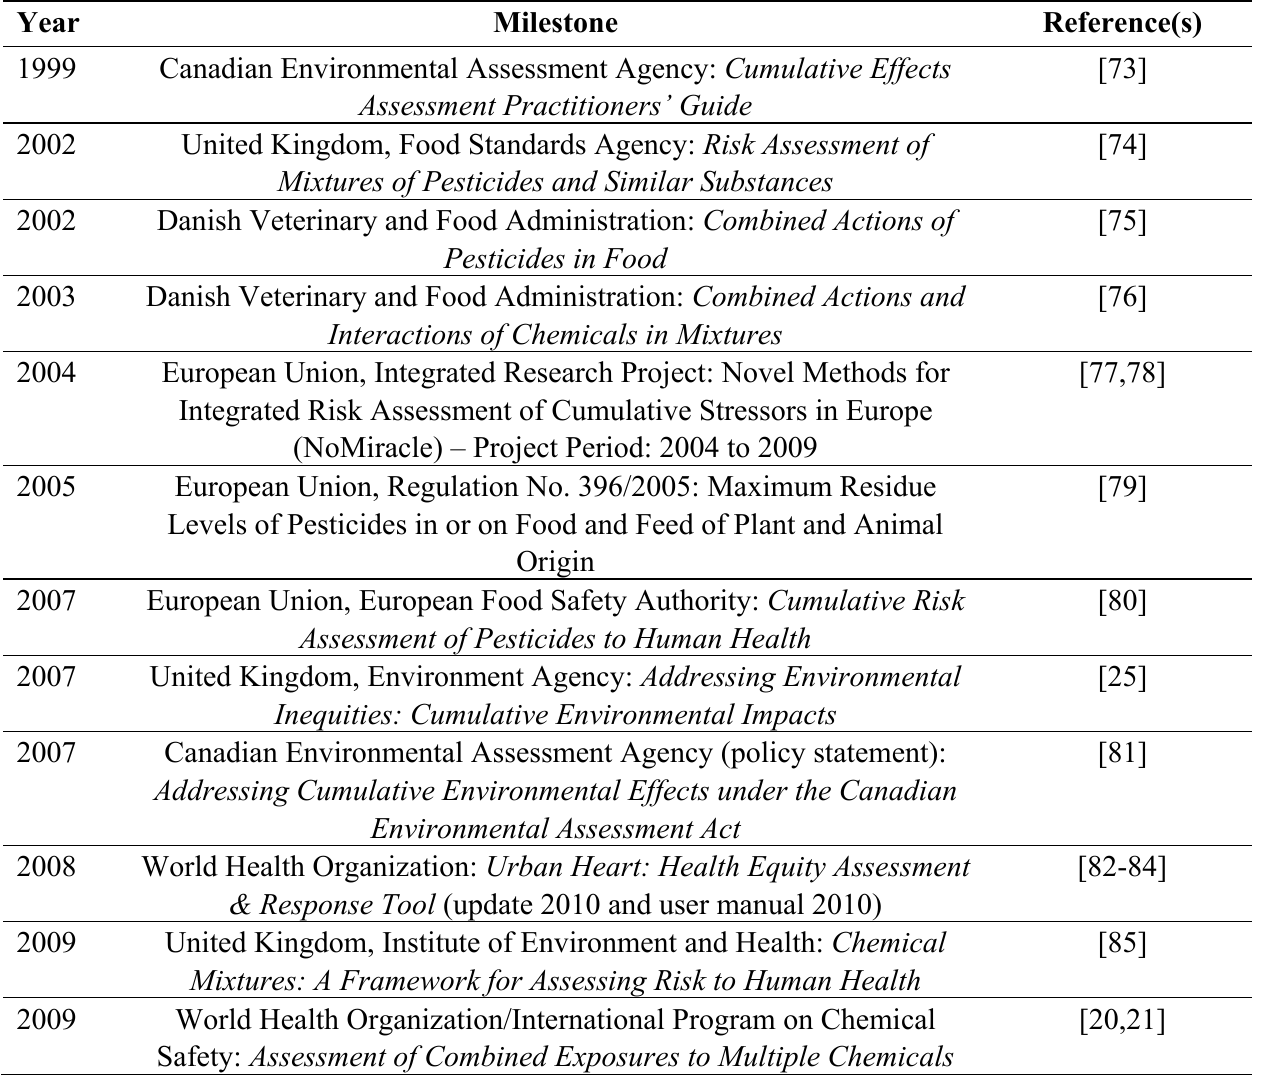
Table 3. Selected Milestones Outside the U.S. in the Evolution of Cumulative Risk Assessment for Combined Health Effects from Multiple Environmental